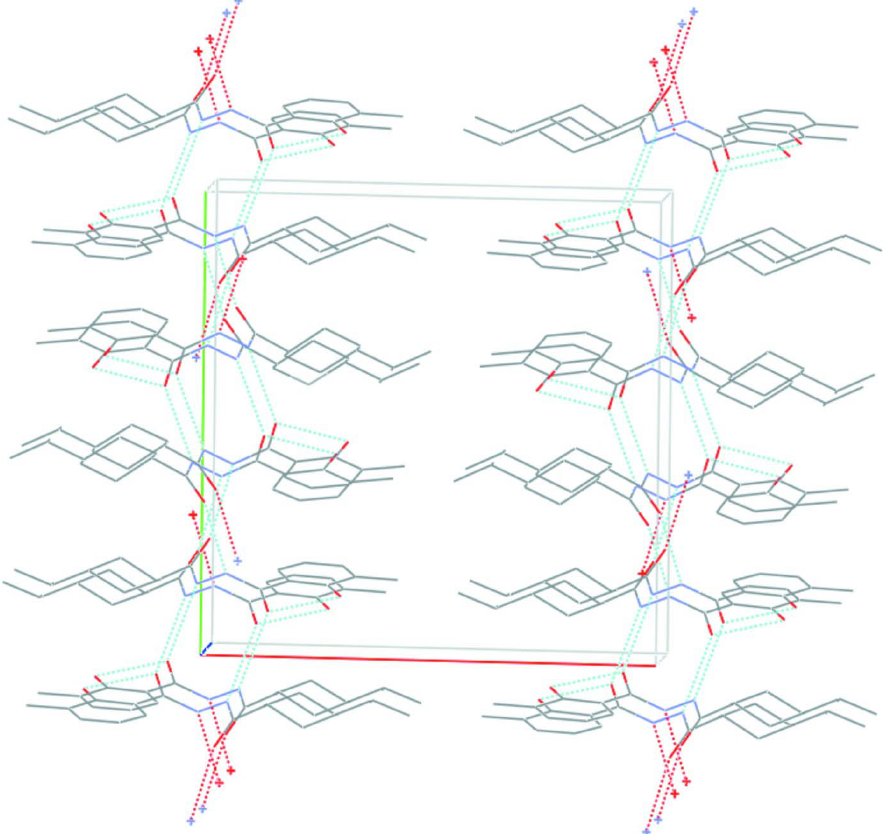
Figure 2 Packing diagram of (I). hydrogen bonds are shown as dashed